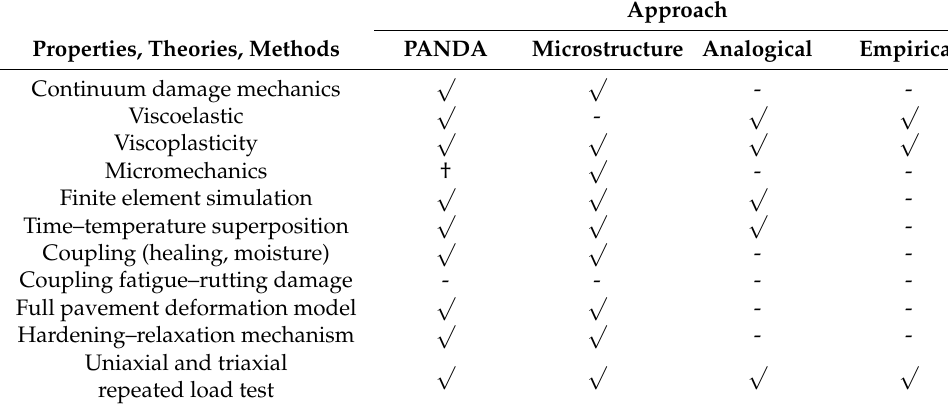
Table 5. Summary of permanent deformation modeling